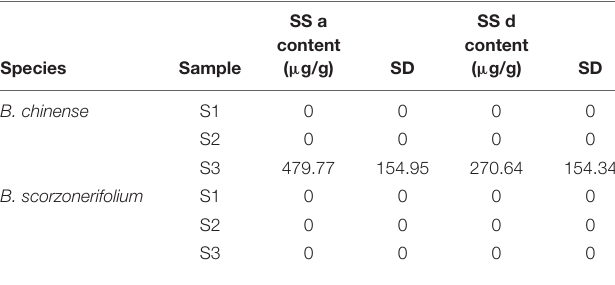
TABLE 1 | Contents of saikosaponin a and saikosaponin d in the roots of B. chinense and B.